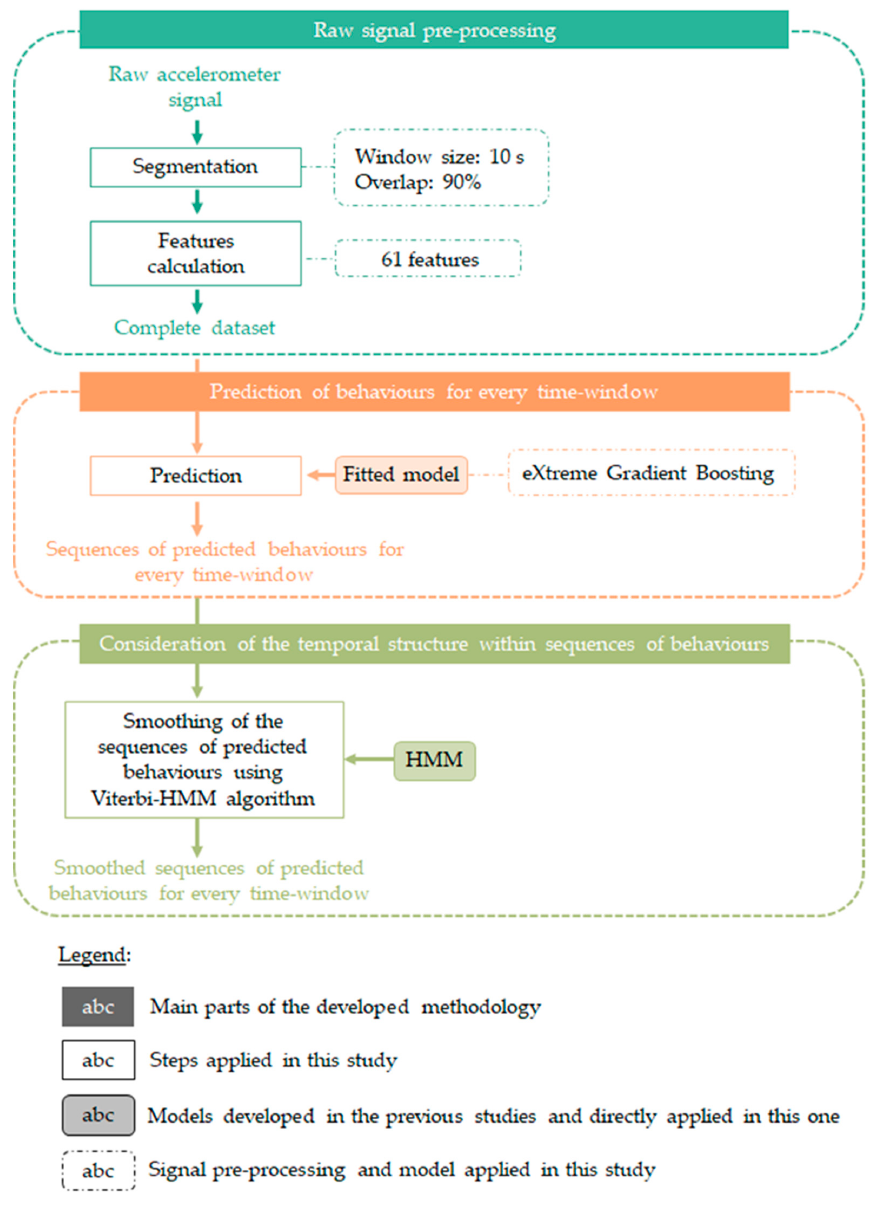
Figure 3. Description of the successive stages carried out in this study to obtain the predicted behaviors of dairy cows during the